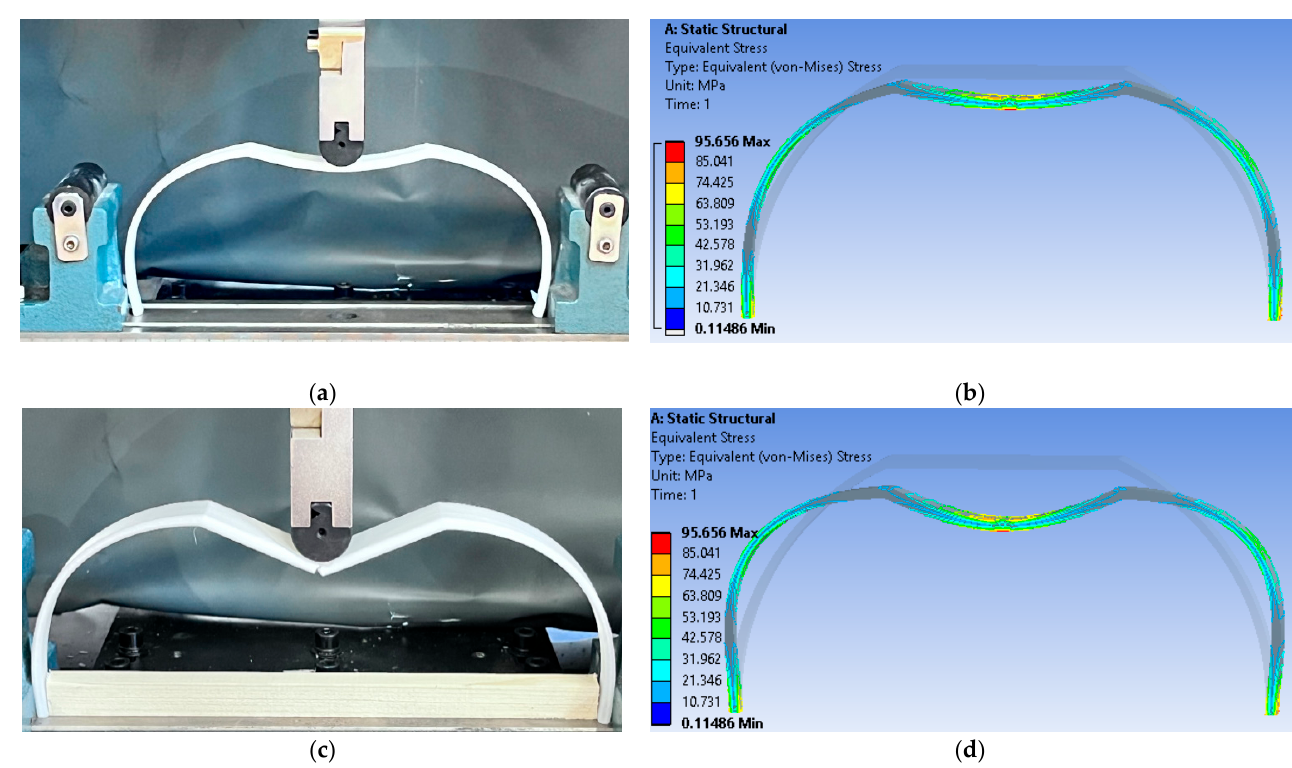
Figure 6. Testing of the landing gear models includes the following scenarios: ( a ) intermediate stage during the PLA GF landing gear’s three-point bending test; ( b ) deformation mode of the PLA GF landing gear from the finite element analysis; ( c ) rupture of the PLA GF landing gear; ( d ) rupture of PLA GF landing gear simulation.